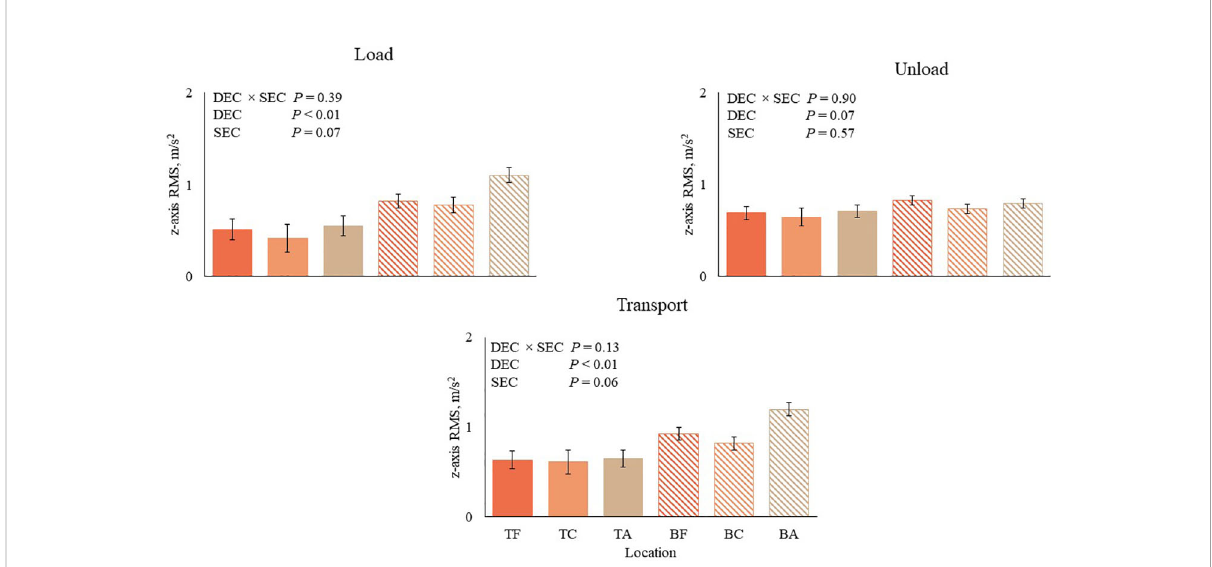
FIGURE 4 Weighted z-axis root mean square (RMS) experienced by pigs transported within two decks (DEC; T, Top; B, bottom) and three sections (SEC; F, fore; C, center; A, aft) located within two trailers during loading, transport, and unloading. Two trailers transported two daily market-weight pig loads over 5 consecutive days.